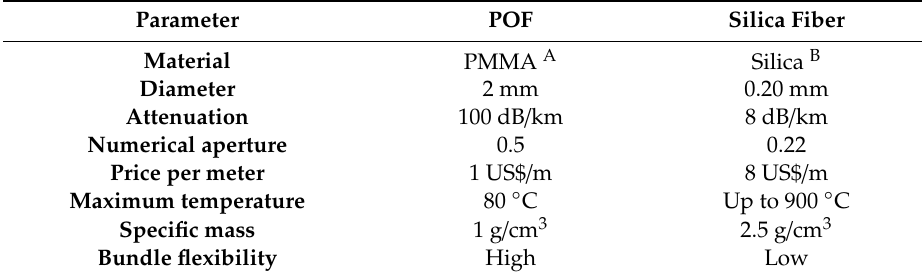
Table 6. Comparison of di ff erent characteristics between Plastic optical fiber (POF) and silica fiber